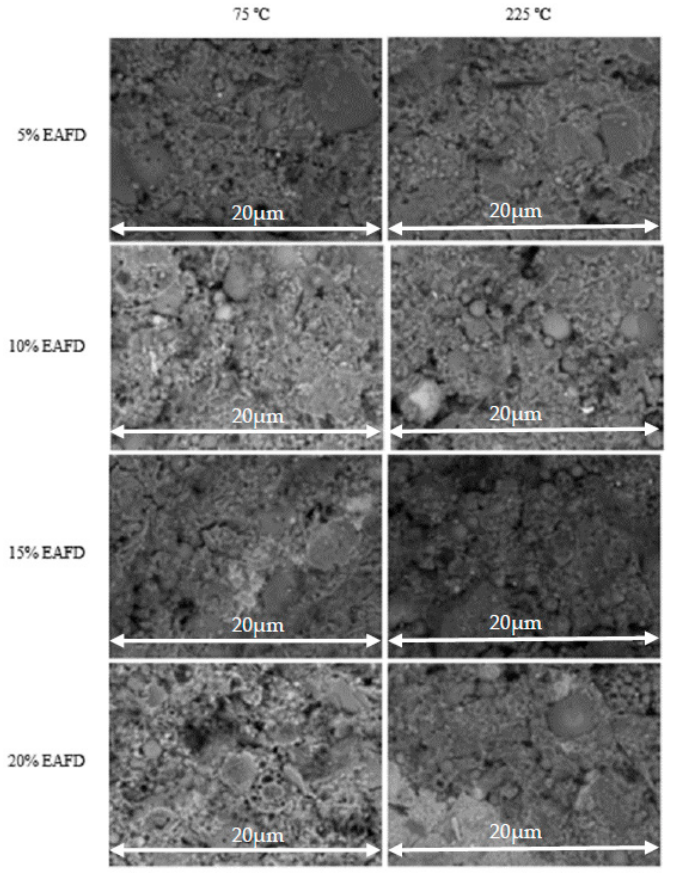
Figure 2. Microstructure of the geopolymer matrices with different dosages of EAFD and curing temperatures.